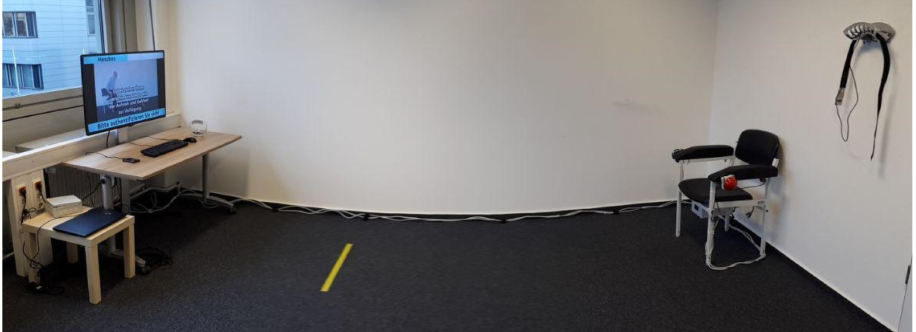
Figure 1. The Initial prototype comprises the main components of user interaction within the system and has been used for the user interaction study.